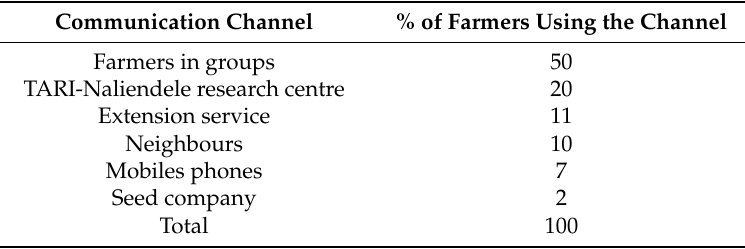
Table 4. The communication channels through which farmers receive information about seeds (n = 300).